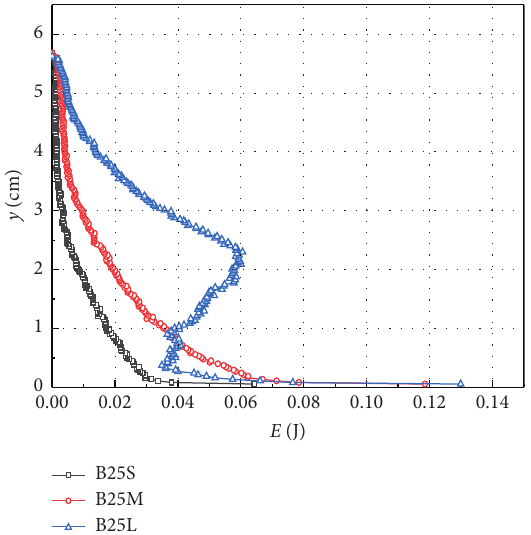
Figure 18: The vertical distribution of the kinetic energy in dif- ferent working